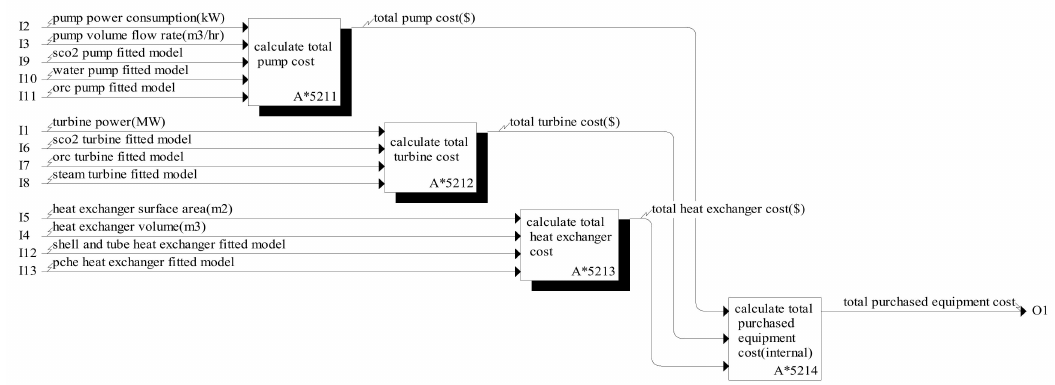
Figure 4. Functional architecture of TCI estimation module.